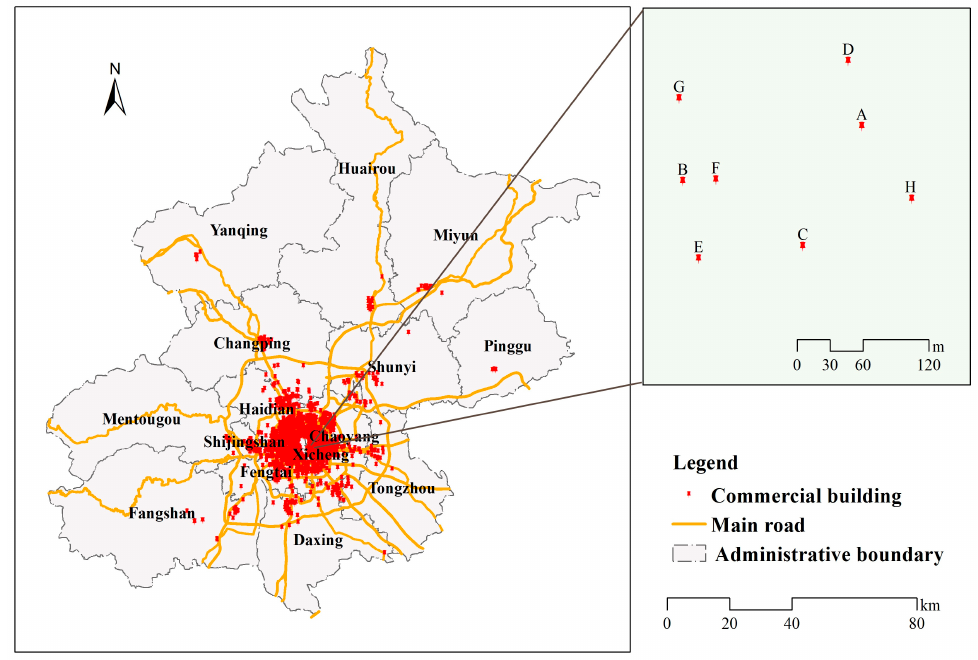
Figure 3. Distribution of commercial buildings at the global and local scales, respectively. Table 2. Detailed information of the commercial buildings at the local scale.